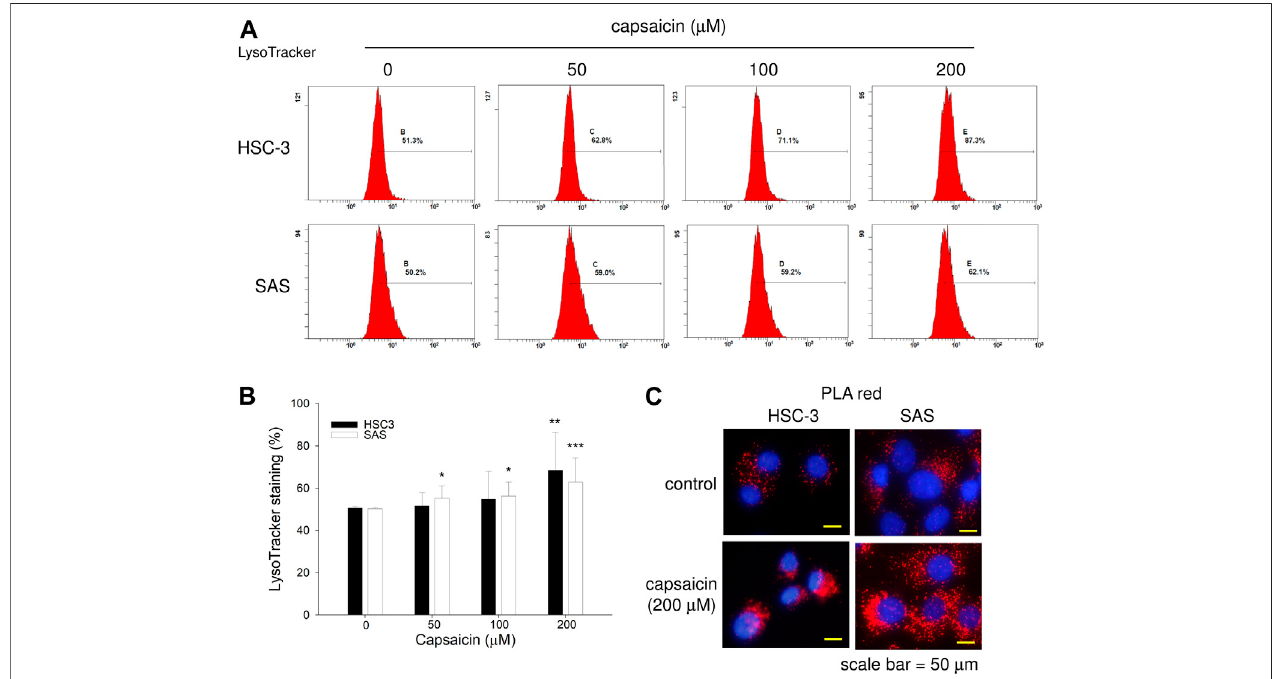
FIGURE4| Effectofcapsaicinonlysosomefunction. (A,B) Cellsweretreatedwithdifferentconcentrationsofcapsaicinfor48 h,treatedwith1 μ MLysoTrackerfor 30 min,andanalyzedby fl owcytometry. (C) Cellsweretreatedwithcapsaicinfor24 h,andPLAwasusedtoexaminetheco-localizationofLC3-IIandribophorinII.Data are representative of three to six independent experiments. Scale bar (cid:2) 50 μ